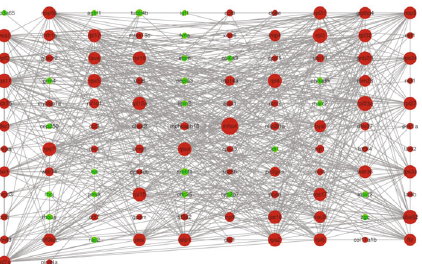
Figure 4: Protein-protein interaction network of di ff erentially expressed genes. Each node represents the protein corresponding to the di ff erentially expressed gene (green means downregulation, while red means upregulation). The edges represent the interactions between the